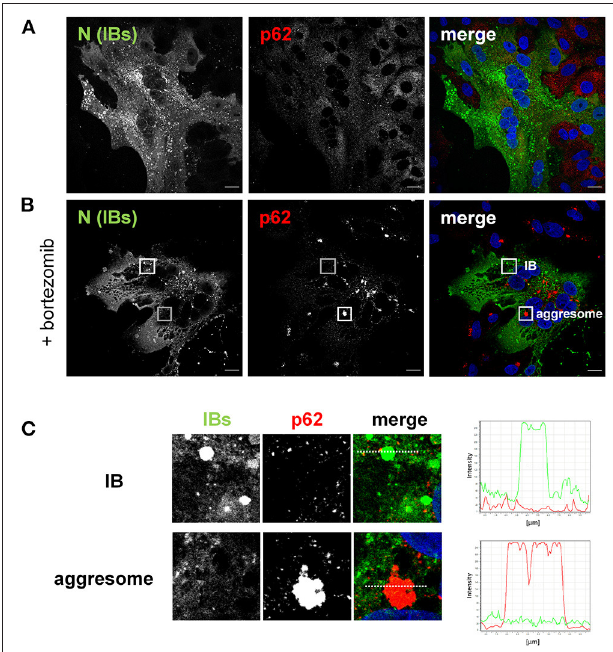
FIGURE 3 | Aggresome formation in NiV-infected cells . Vero76 cells were infected with NiV at an MOI of 0.05 in the absence (A) or presence of 50nM bortezomib (B) . At 24h p.i. cells were fixed with 4% PFA for 10min and permeabilized with methanol/acetone. The aggresome marker p62 was labeled with a specific antibody (red). Then, cells were fixed with 4% PFA for further 48h. After removal from the BSL-4 lab, cells were stained with a NiV N antiserum to visualize IBs (green). Nuclei were counterstained with DAPI (blue). Scale bars, 10 µ m. (C) Enlarged views of the areas marked by the white boxes in (B). The histograms in the right panel show the fluorescence intensity profile of the respective colors along the dotted line through an aggresome and an